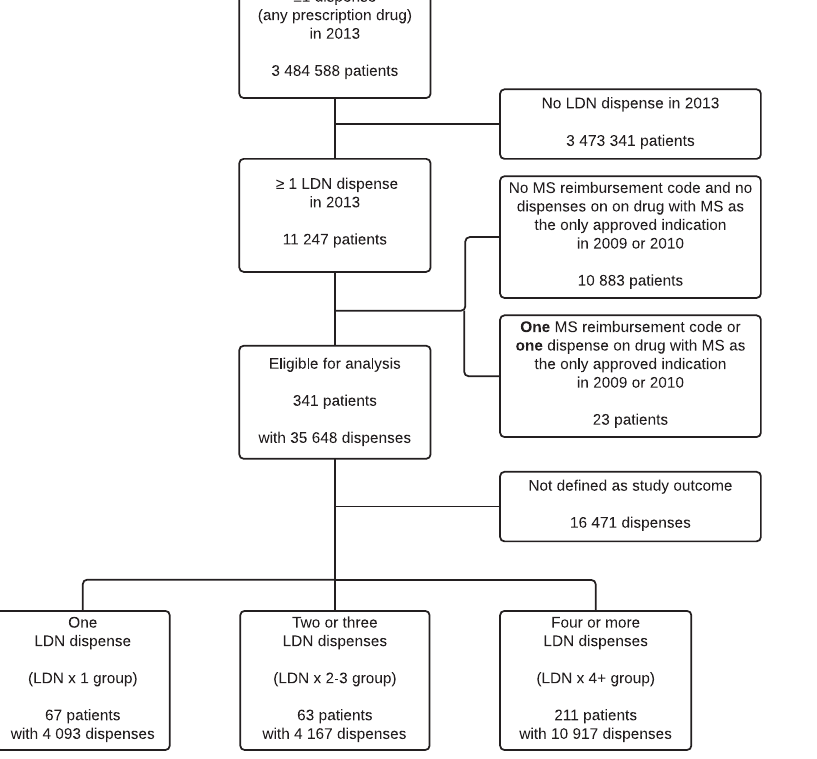
Fig 1. Flowchart of the inclusion of patients and dispensed